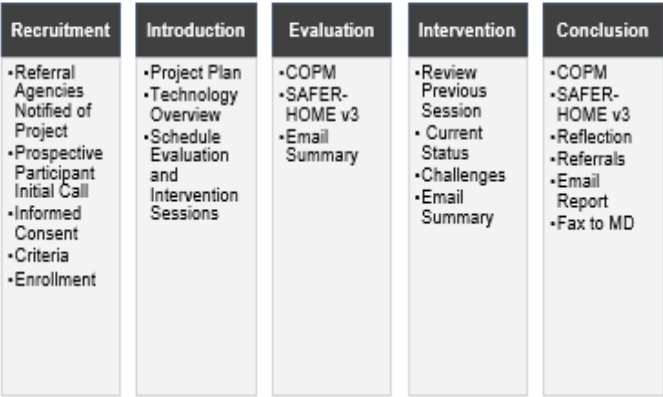
Figure 1. Phases of the study implementation. The figure illustrates the order of the study implementation phases, including a list of activities completed within each